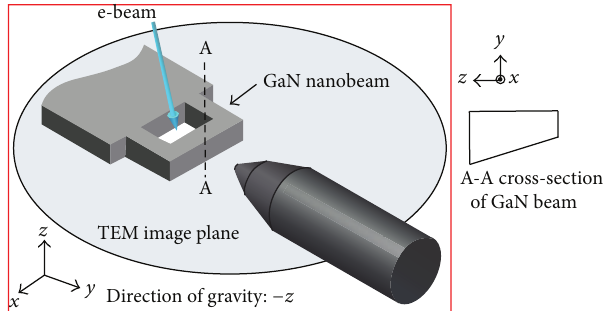
Figure 1: A schematic illustration showing a single crystal GaN nanobeam machined by FIB and a nanomechanical test and loading direction of a nanobeam in TEM. The right part is a cross-section view of GaN nanobeam with a cross-section area of 0.03125 𝜇 m 2 after machining by